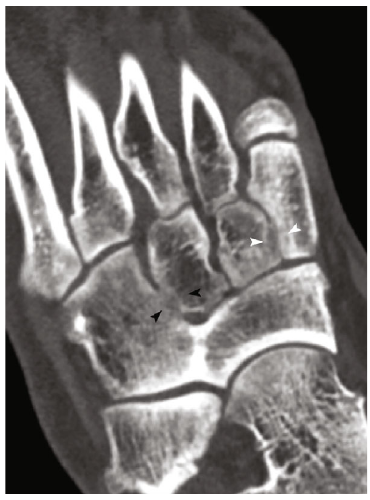
Figure 6: Oblique multiplanar reconstruction CT image of the right foot shows osseous cubonavicular coalition, associated with a partial osseous coalition between the cuboid and the third cuneiform with a focal lack of subchondral bone plate (black arrowheads) and bone irregularities between the fi rst and second cuneiforms suggesting a nonosseous coalition (white